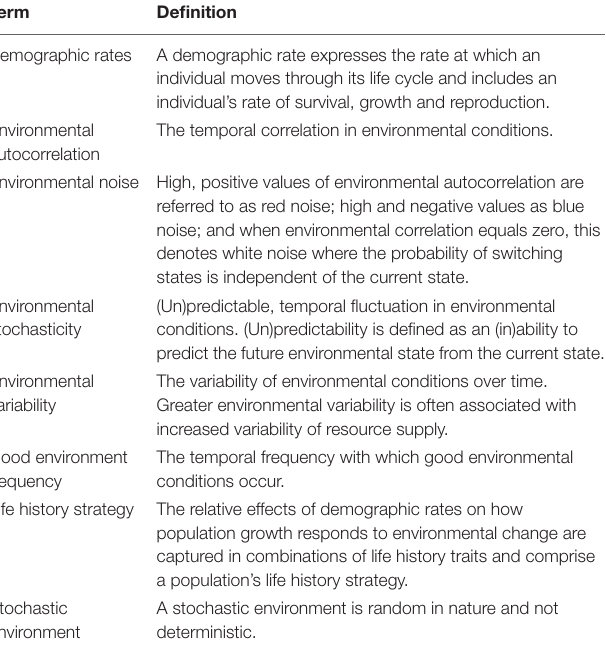
TABLE 1 | Definitions of important